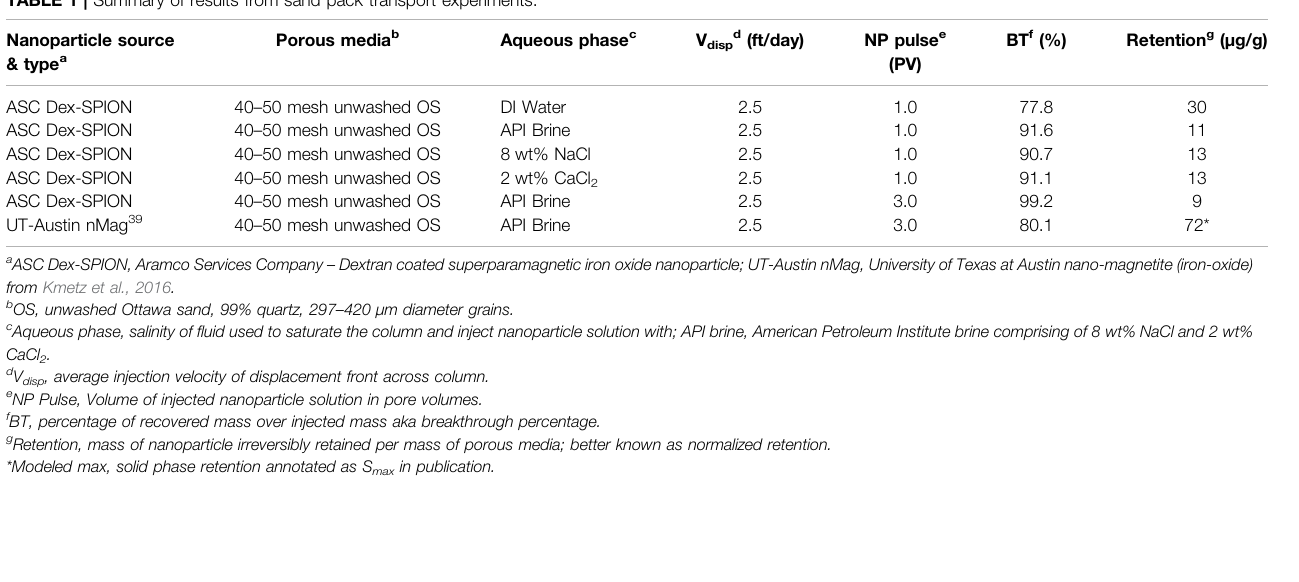
TABLE 1 | Summary of results from sand pack transport